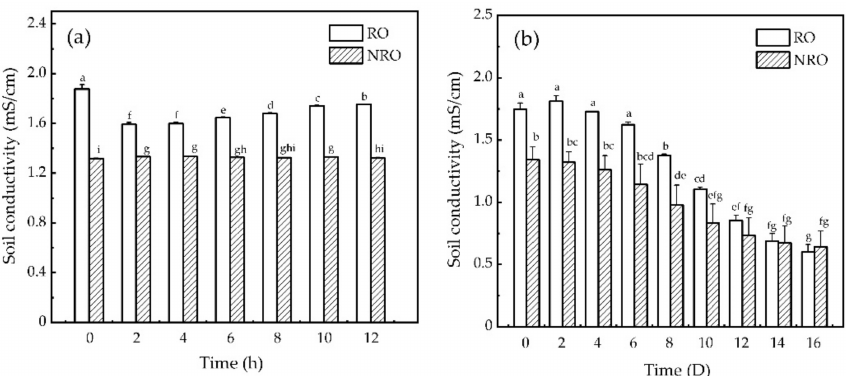
Figure 4. Diurnal and day-to-day variations in soil conductivity in two habitats. ( a ) Diurnal variation of soil conductivity under drought conditions. ( b ) Day-to-day variation of soil conductivity under drought conditions. RO and NRO represent the rock outcrop habitat and the non-outcrop habitat, respectively. Small letters indicate significant differences at 5% level p < 0.05